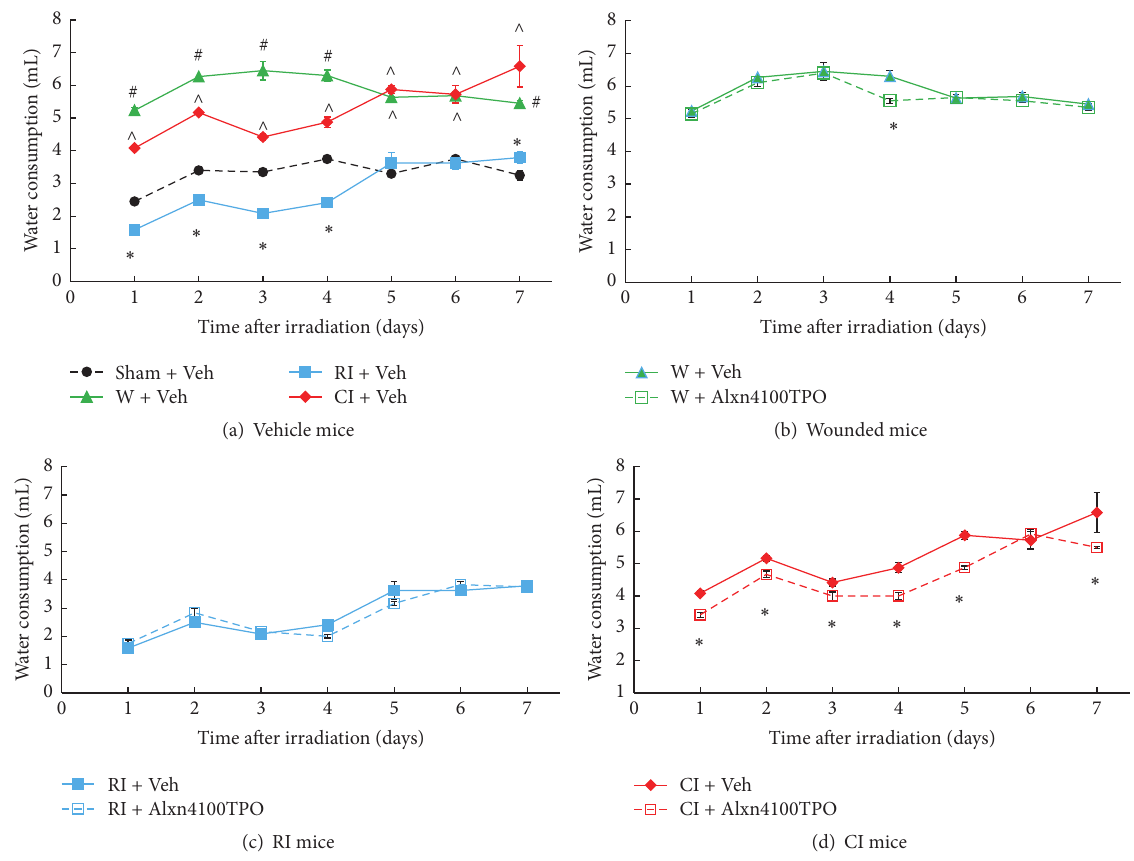
Figure 8: RI decreased and CI increased water consumption and Alxn4100TPO significantly decreased the CI-enhanced water consumption. The daily water consumption was monitored for 7 days after wounding, RI, or CI. 𝑁 = 19–22 per group. Data are presented as mean ± SEM. For panel (a): ∗ 𝑝 < 0.05 versus sham, wound, and CI; ∧ 𝑝 < 0.05 versus sham, wound, and RI; # 𝑝 < 0.05 versus sham, RI, and CI. For panel (b), ∗ 𝑝 < 0.05 versus W + Vehicle. For panel (d): ∗ 𝑝 < 0.05 versus CI + Vehicle. Veh: vehicle; W: wound; RI: 9.5 Gy; CI: 9.5 Gy and skin